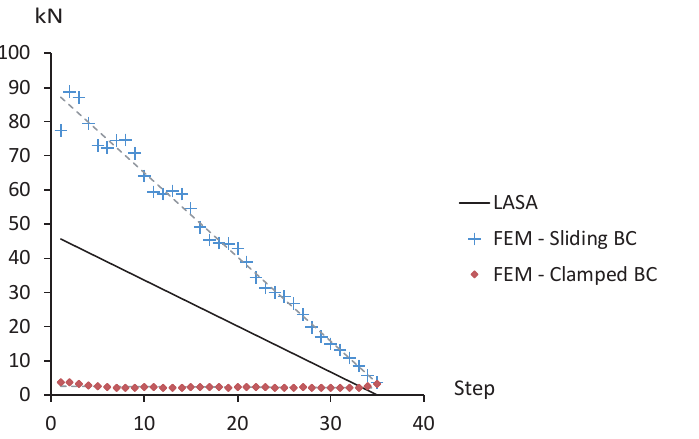
Figure 9. Helicoidal staircase of Nisida: comparison between the thrust corresponding to the line 4 (violet line in Figures 6a and 7) obtained with LASA and FEM analyses. Note: dashed gray lines mark linear interpolation of